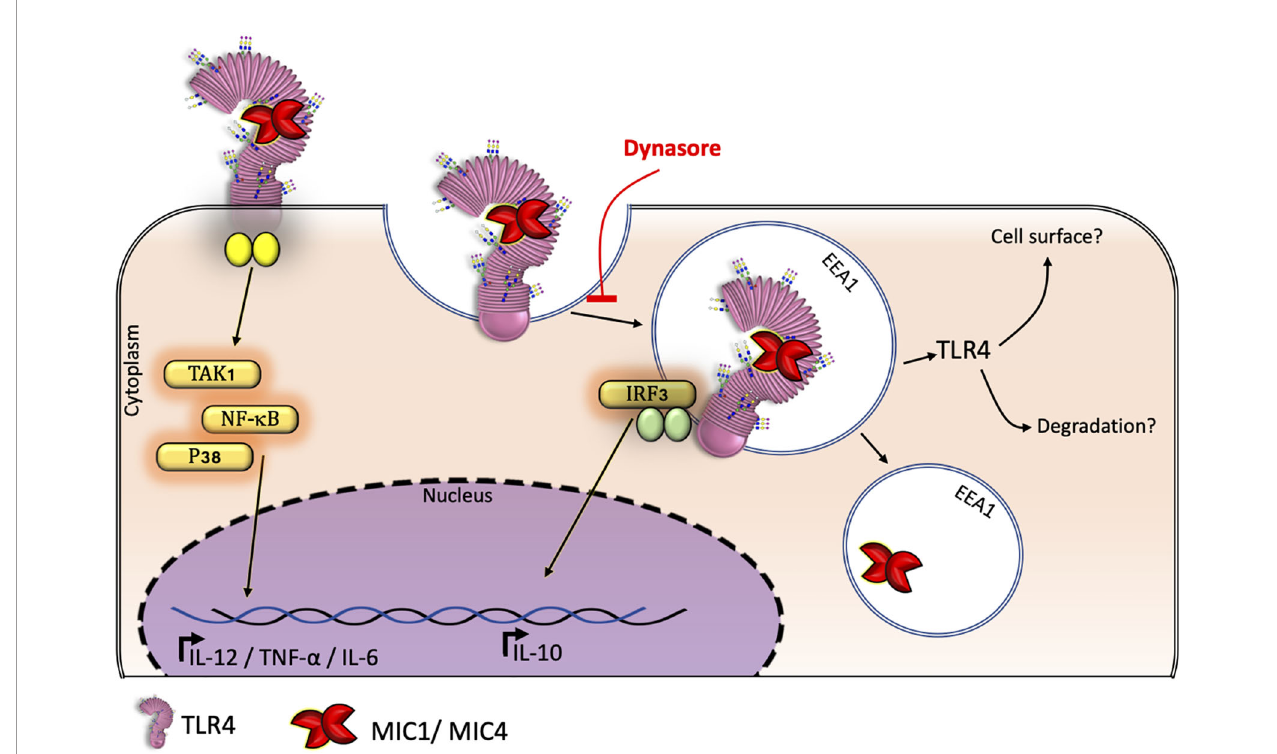
FIGURE 6 | Tg MIC1 and Tg MIC4 drive TL4 into endosomes inducing BMDM-IL-10 release: a model. BMDMs produce the anti-in fl ammatory cytokine IL-10 in response to MIC 1 and MIC4 depending on TLR4 internalization from the cell surface. Macrophages subjected to blockage of endocytosis by Dynasore continued to release the proin fl ammatory cytokine TNF- a but failed to produce IL-10 in response to MIC1 or MIC4